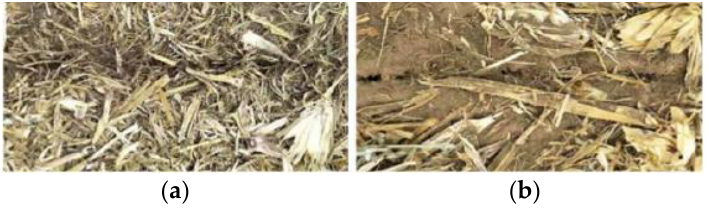
Figure 7. Field experiments for disparate types of furrow openers coordinate with a water jet: ( a ) Double-disc opener; ( b ) Hoe opener ([22], adopted from “Anti-blocking performance of ultrahigh- pressure waterjet assisted furrow opener for no-till seeder” with permission from IJABE Editing and Publishing Office, 2022).